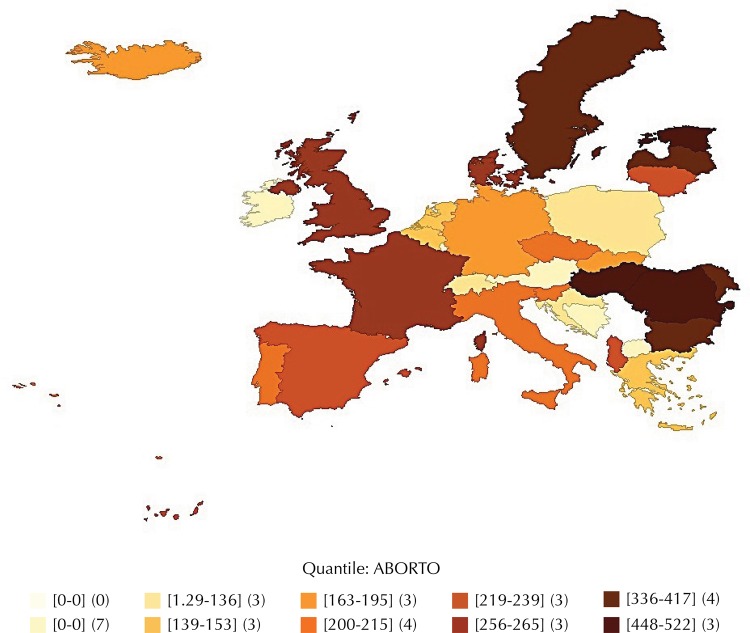
Abortos por mil nacimientos vivos en Europa durante el año 2009*.